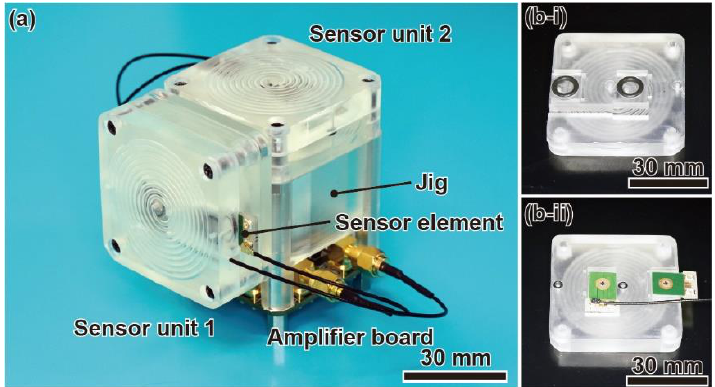
Figure 6. Photographs of ( a ) the developed angular acceleration sensor, ( b-i ) the upper part of sensor unit, and ( b-ii ) the lower part of sensor unit with sensor elements.